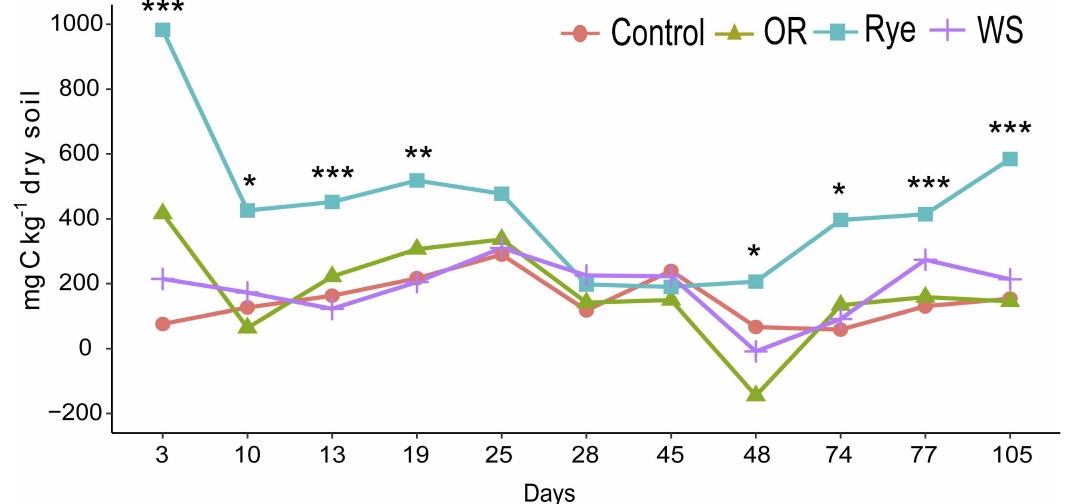
Figure 4. The microbial biomass carbon (MBC) evolution in each of four treatment conditions over a 105-day incubation period: soil only (Control), soil mixed with oilseed rape residues (OR), soil mixed with rye residues (Rye), and soil mixed with wheat straw (WS). Stars indicate significant di ff erences between treatments within the same day according to one-way ANOVA (* p < 0.05, ** p < 0.01, and *** p <